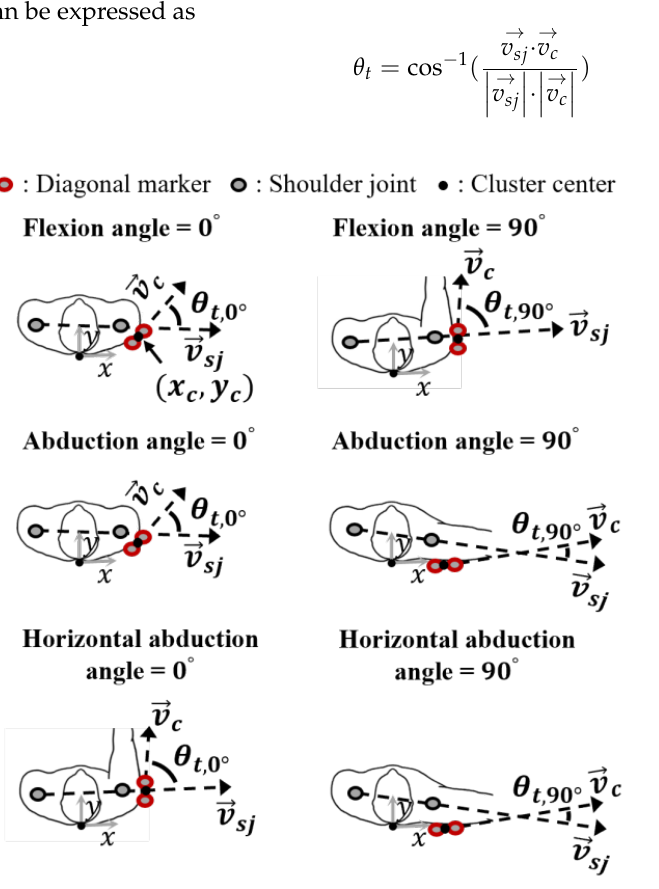
Figure 3. Determination of target orientation ( 𝜃 𝑡 ) using a cluster when the arm elevation angle is 0° and 90° during each motion.